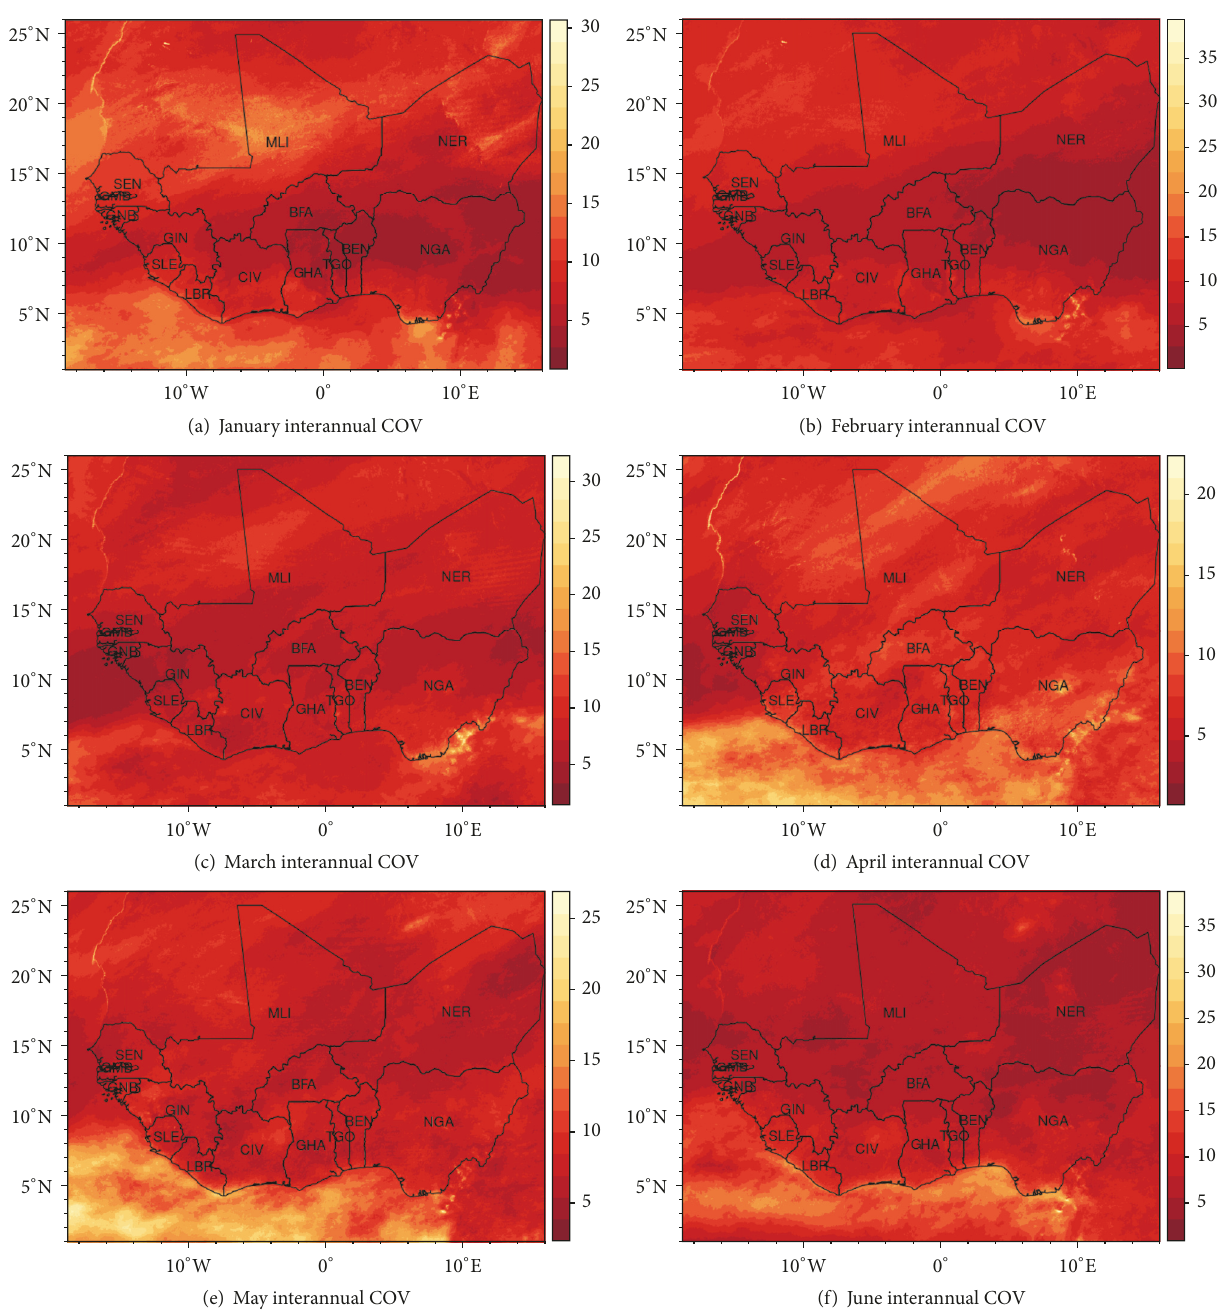
Figure 3: Monthly solar resources coefficient of